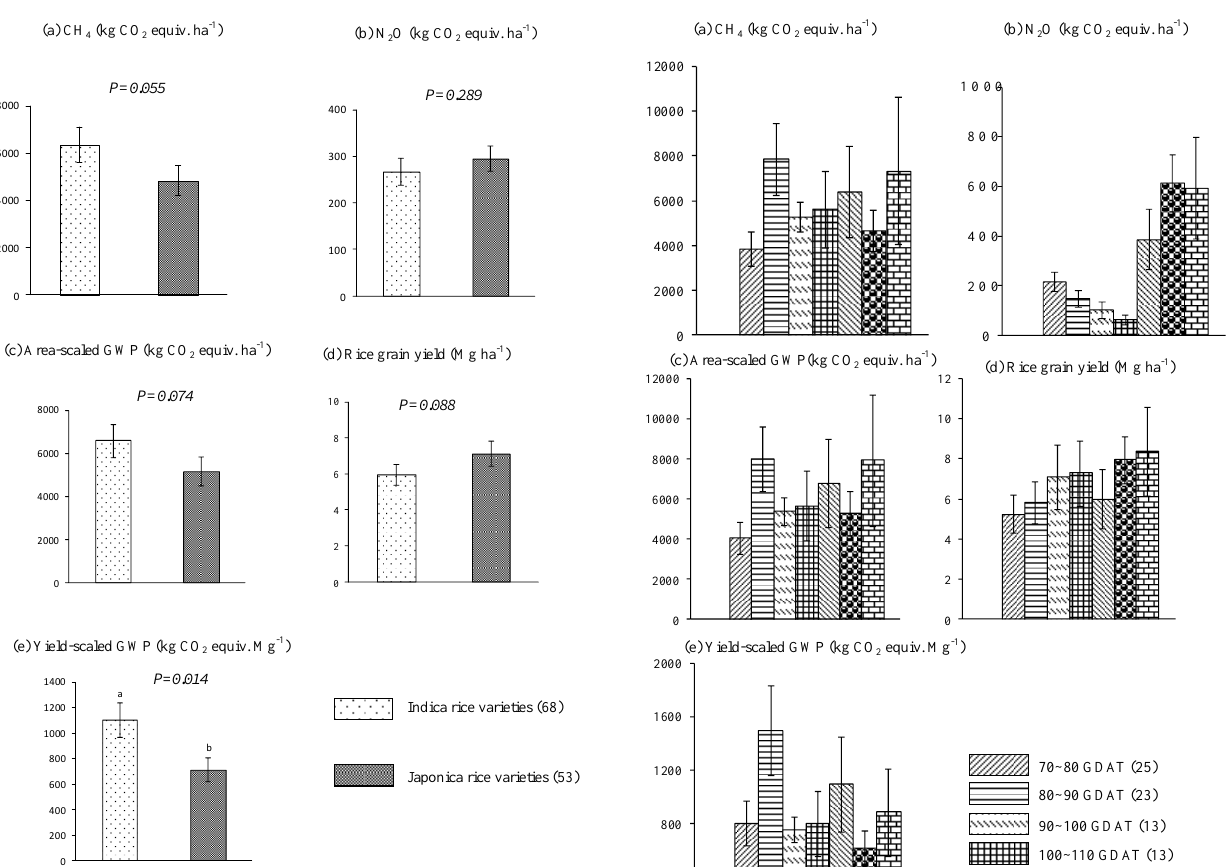
Figure 1. Impacts of cropping systems on CH 4 and N 2 O emissions, area-scaled GWP, rice grain yield, and yield-scaled GWP during rice varieties types. The data in the bracket were the numbers of observation. All error bars represented 95% confidence intervals. Figure 2. Impacts of cropping systems on CH